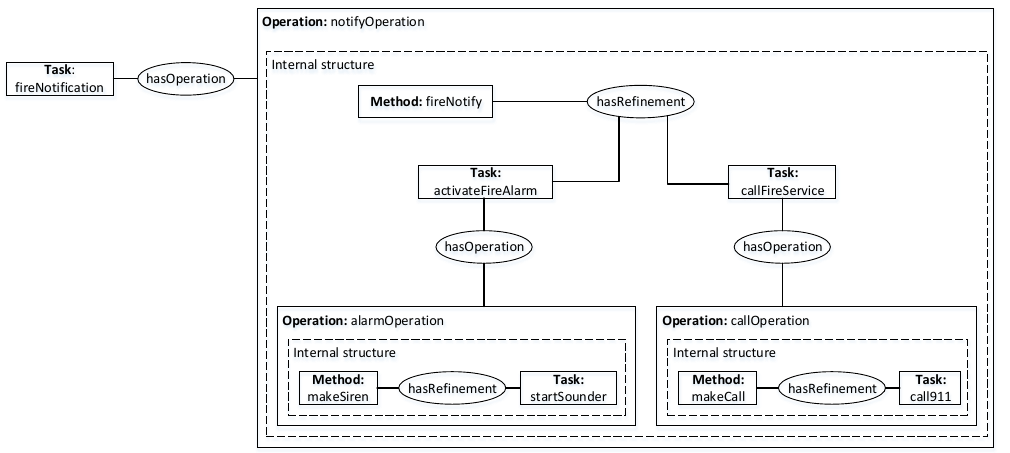
Figure 5. An example of a nested conceptual graph of task